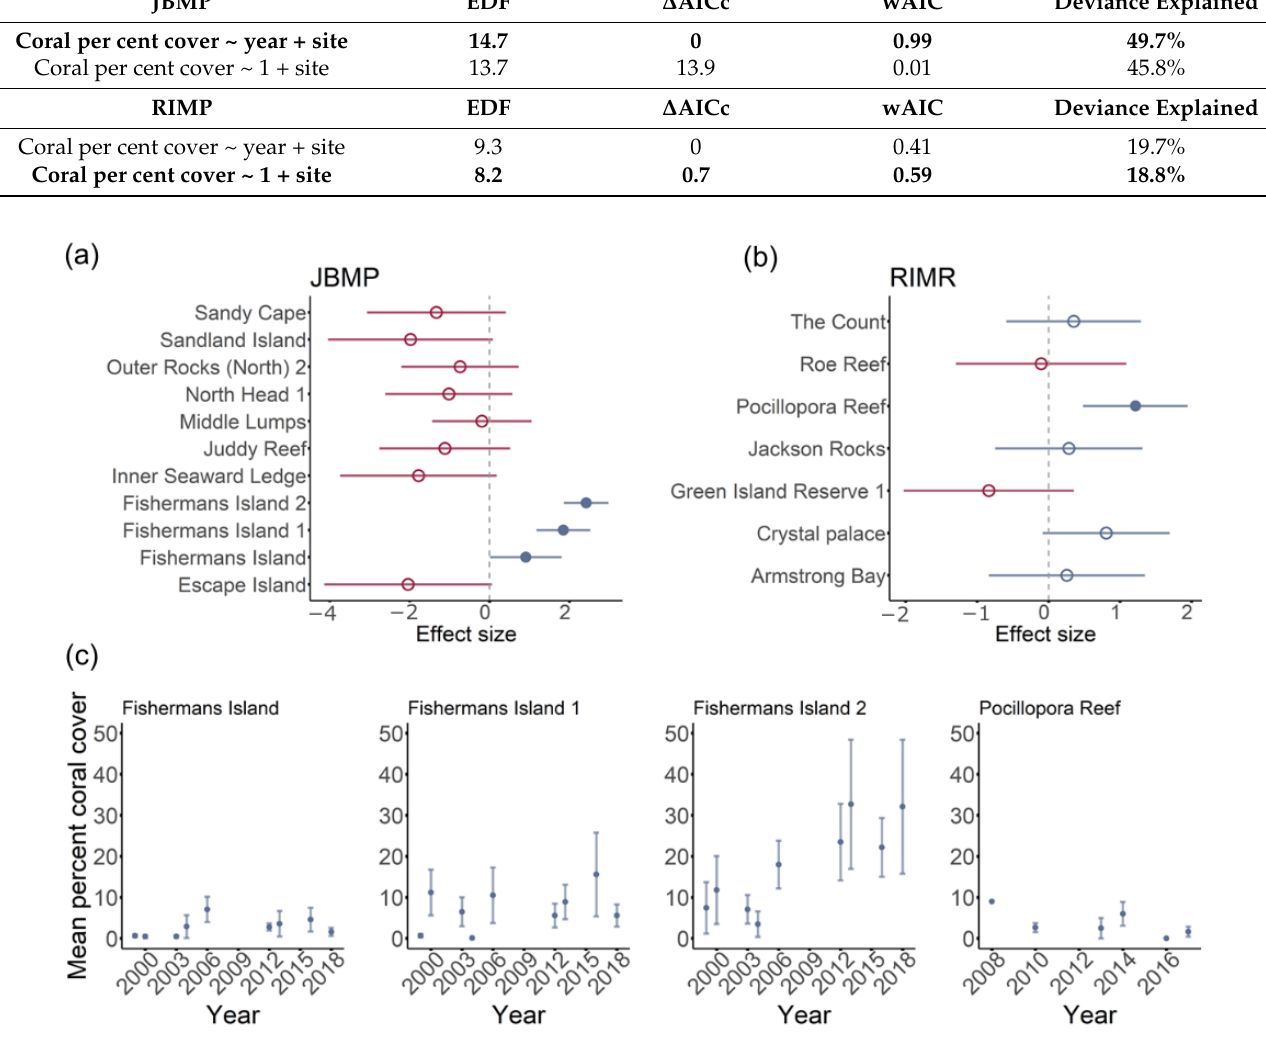
Figure 5. Effect sizes for the per cent coral cover through time in Jurien Bay Marine Park ( a ) and Rottnest Island Marine Reserve ( b ). Red dots represent negative effects sizes and blue dots positive effects sizes. Closed dots represent results where the 95% confidence interval of the effect size does not overlap zero. For these sites, temporal trends in mean per cent coral cover are presented ( c ).